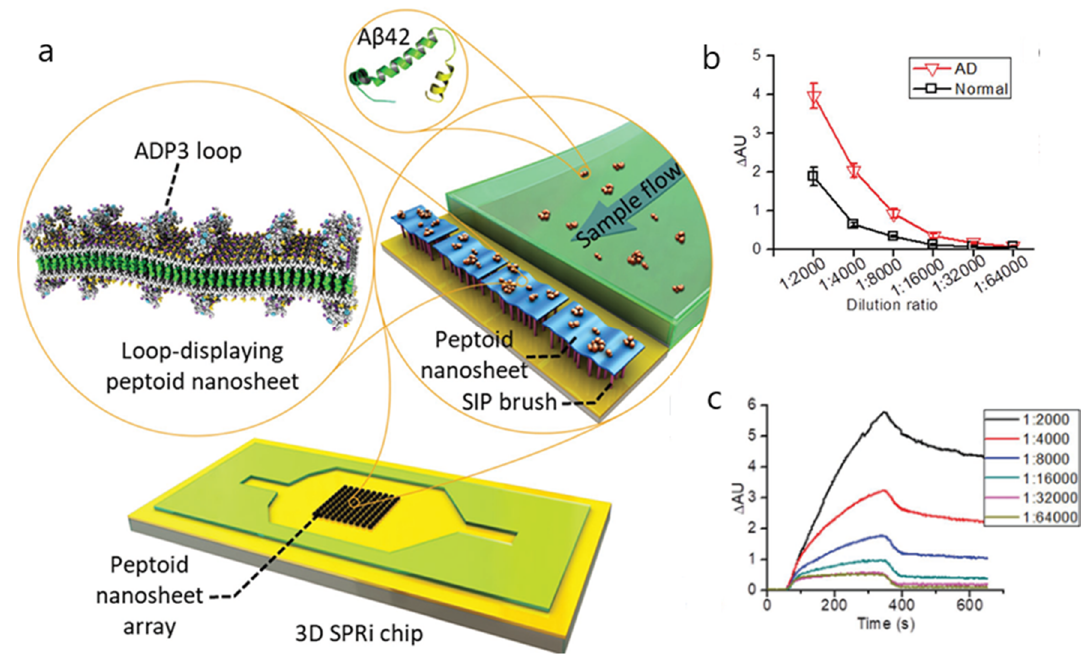
Figure 8. ( a ) Schematic illustration of the detection of Alzheimer’s disease (AD) serum by loop-displaying peptoid nanosheets in combination with 3D surface plasmon resonance imaging (SPRi) sensor chip. The AD peptoid 3 (ADP3) loop-displaying peptoid nanosheets were immobilized on the 3D sensor chip with carboxylated poly(OEGMA-co-HEMA) brushes fabricated on the gold surface by surface-induced polymerization (SIP). As the serum sample flow passed through the chip, Aβ42 in the serum was captured by the ADP3 loop in the nanosheet, generating SPRi binding signals. ( b ) Evaluation of the sensitivity of the ADP3 loop-displaying peptoid nanosheets to detect AD sera. SPRi binding signals of nanosheets with 100% ADP3 loop to AD and normal sera at different dilution ratios are shown. Error bars represent the standard deviation (n = 14). ( c ) Representative SPRi sensorgram showing the binding of nanosheets with 100% ADP3 loop to AD serum at different dilution ratios. Reproduced with permission from Zhu et al. [81] (Copyright © (2017) WILEY-VCH).